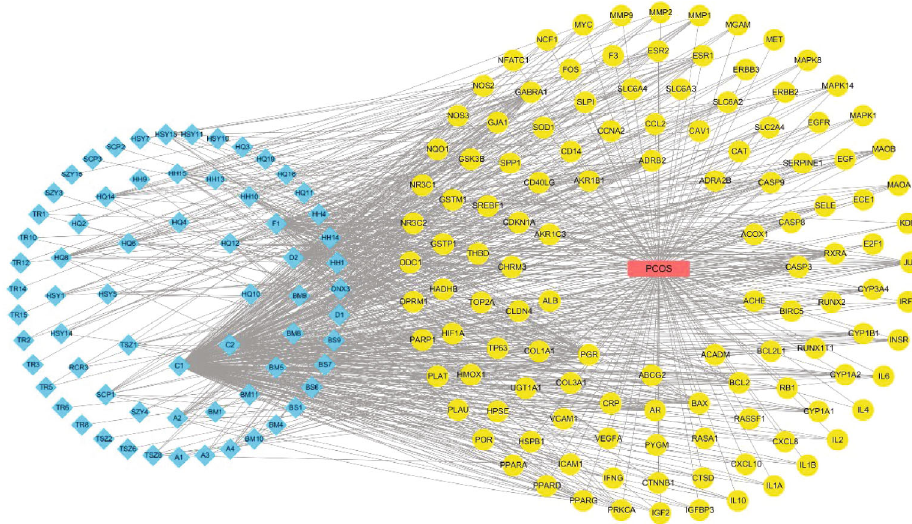
Figure 2: The chemical-target-disease network (the blue diamond represents active drug constitutes of WHQD, while the yellow circle represents the target genes of PCOS. The red rectangle represents